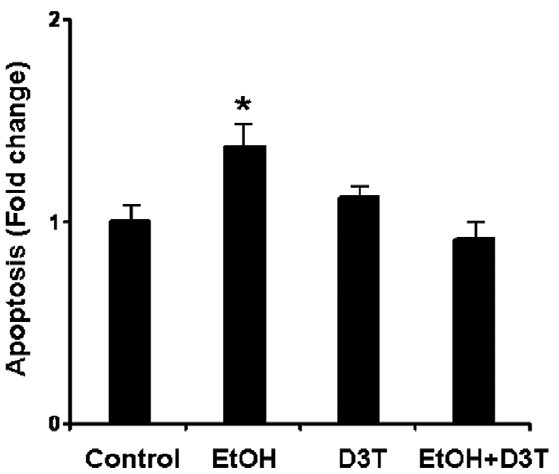
Figure 3. Flow cytometry of apoptotic PC12 cells with Annexin V-FITC showed that D3T treatment significantly prevents ethanol-induced apoptosis. Apoptosis was measured in PC12 cells cultured in control medium (Control), treated with 200 mM ethanol (EtOH), treated with 50 m M D3T alone (D3T), or treated with both ethanol and D3T (EtOH + D3T). Data are expressed as fold change over control and represent the Mean 6 SEM of three separate experiments. * p , 0.05 vs. control. # p , 0.05 vs.